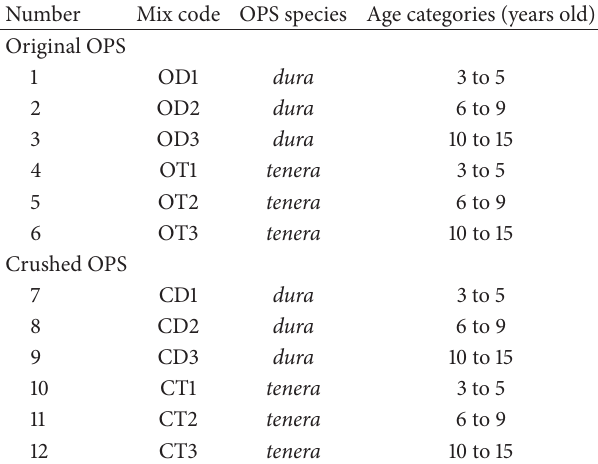
Table 4: Different species of OPS and the age categories of original and crushed OPS